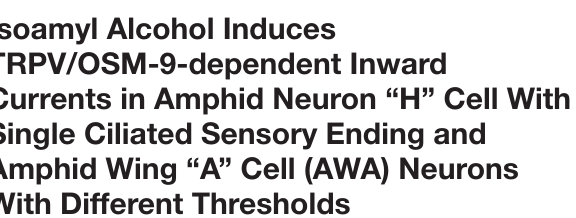
Table 1 ). G α protein ODR-3 and TRPV channel OSM-9